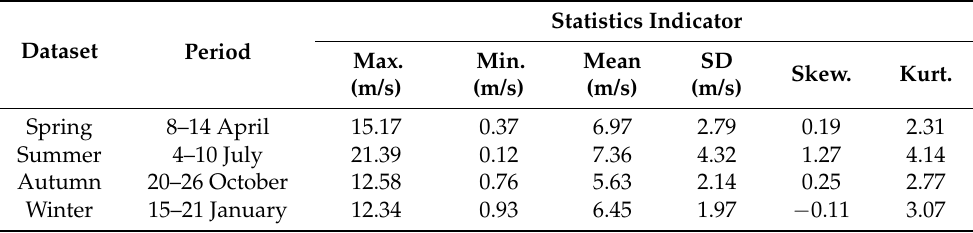
Table 1. Statistical indicators of the four